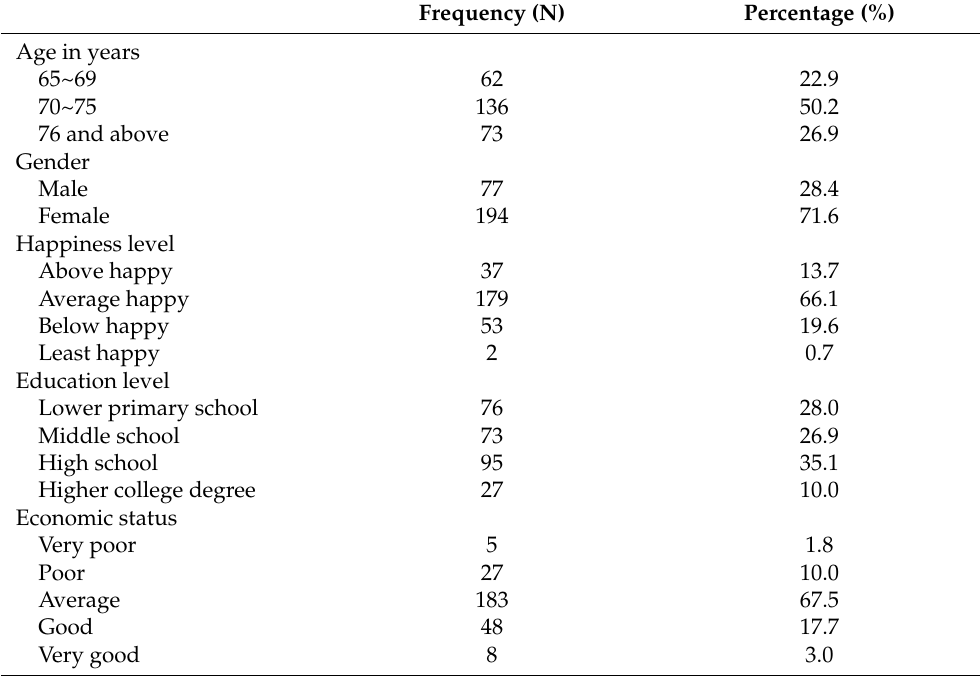
Table 1. General characteristics of